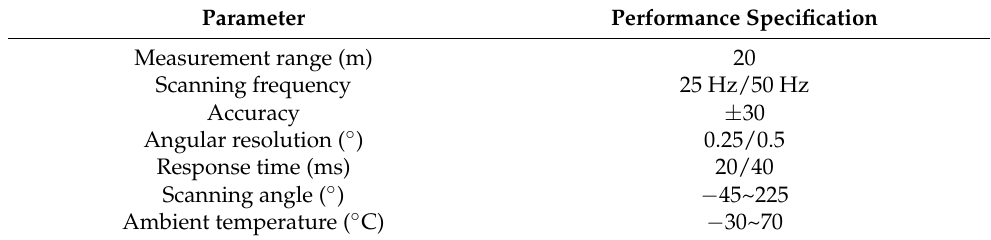
Figure 1. Schematic diagram of the fruit tree canopy point cloud data acquisition system: 1. LiDAR; 2. guide rail; 3. computer; 4. LiDAR power supply; 5. stepper motor power supply; 6. stepper motor controller; 7. stepper motor driver; 8. mobile platform; 9. stepper motor. Table 1. Main parameters of